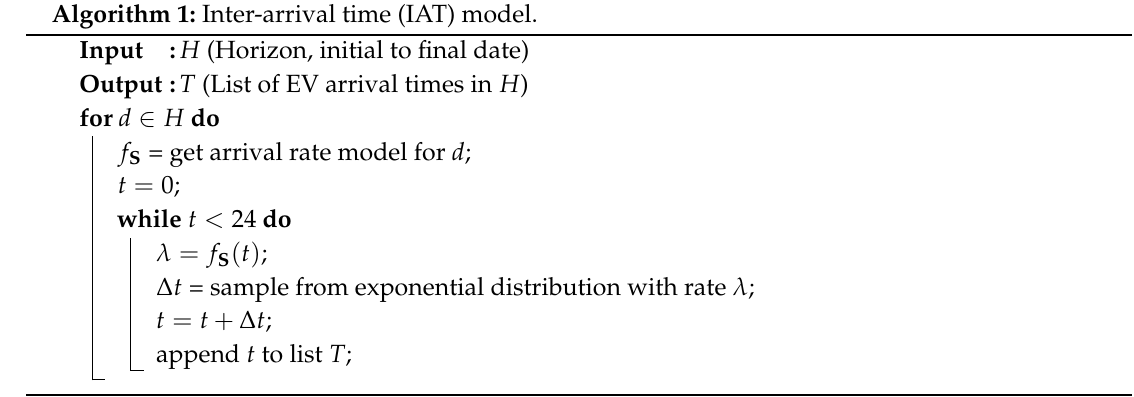
Algorithm 1: Inter-arrival time (IAT)